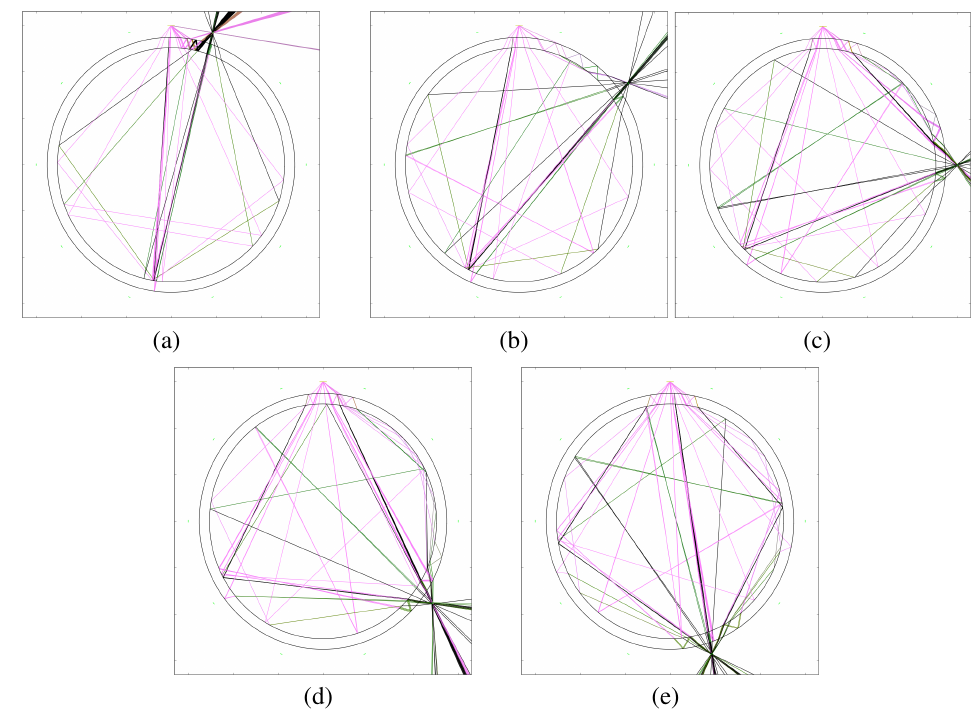
Figure 2. Light paths from a single LED (top of graphs) to five sensors ( a–e ; the other five sensors are their mirror images), including Fig. 2. Light paths from a single LED (top of graphs) to five sensors (a-e; the other five sensors are refraction and reflection (up to 7 times). Colours indicate beam intensity relative to emission, ranging from green (0.001) to pink (0.1), with their mirror images), including refraction and reflection (up to 7 times). Colours indicate beam intensity black segments indicating a relative intensity of less than relative to emission, ranging from green (0.001) to pink (0.1), with black segments indicating a relative intensity of less than 0.001.